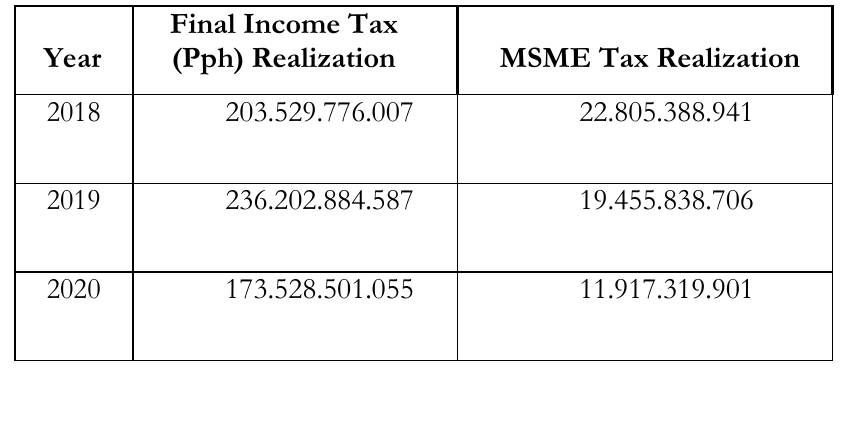
Table. 2 Income Tax Revenue from the MSME